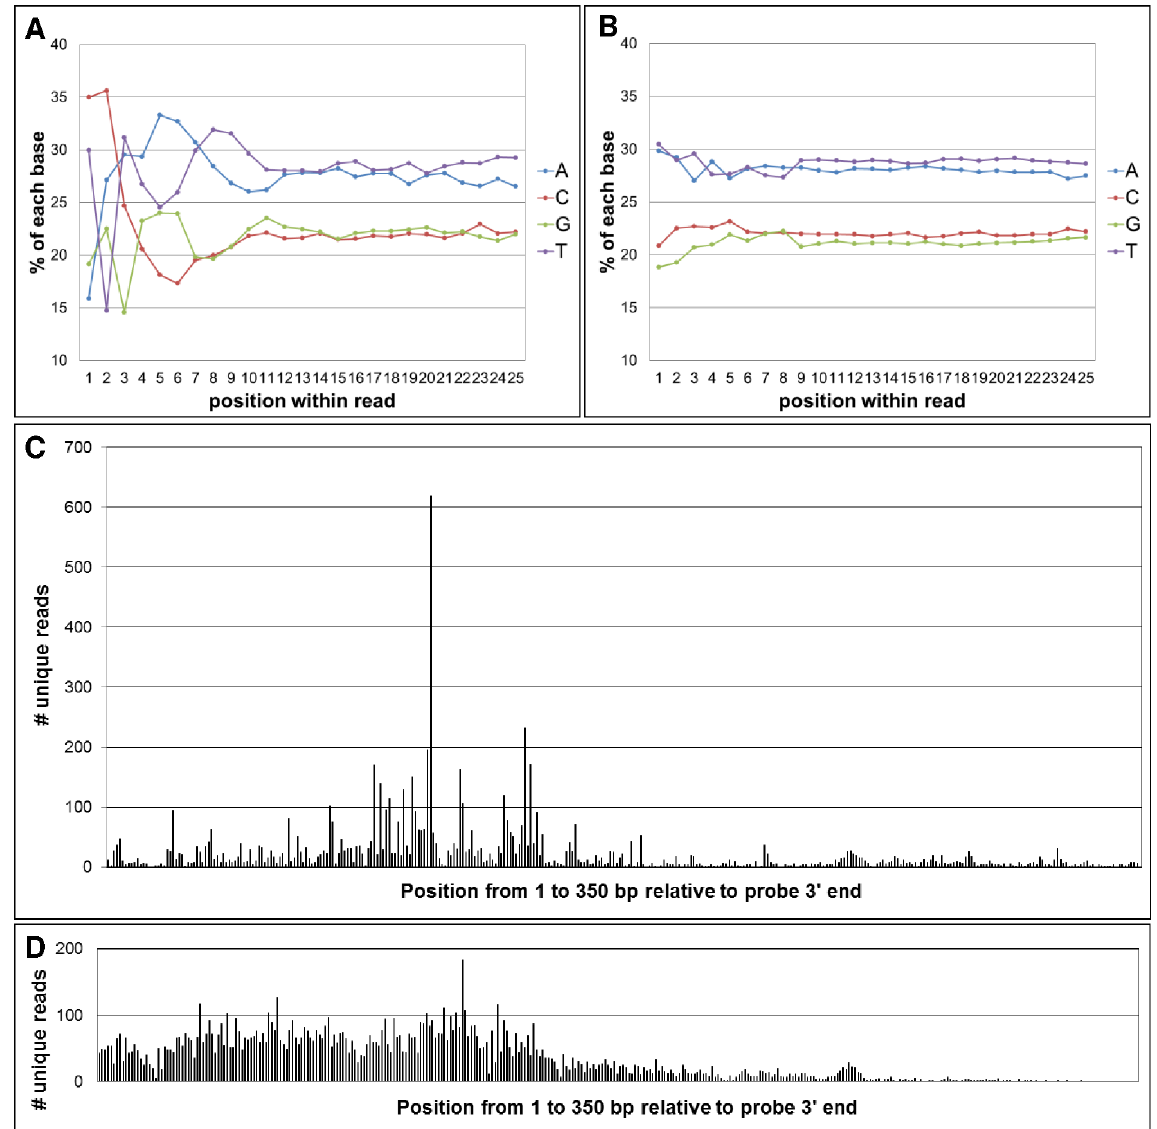
Fig 2. Comparison of cfDNA fragmentation with sonicated DNA fragmentation. (A) The base compositionof the first 25 bases from 100,000independentcfDNA clones. (B) The base composition of the first 25 bases from 100,000independentsonicated-DNA clones. (C) The distributionof 7,781 uniquecfDNA fragmentation sites across 350 base pairs. The 3’ end of the capture probe corresponds to base position 0. (D) The distributionof 11,384 uniquesonicatedfragmentation sites across the same 350 base pair segment shown in Fig